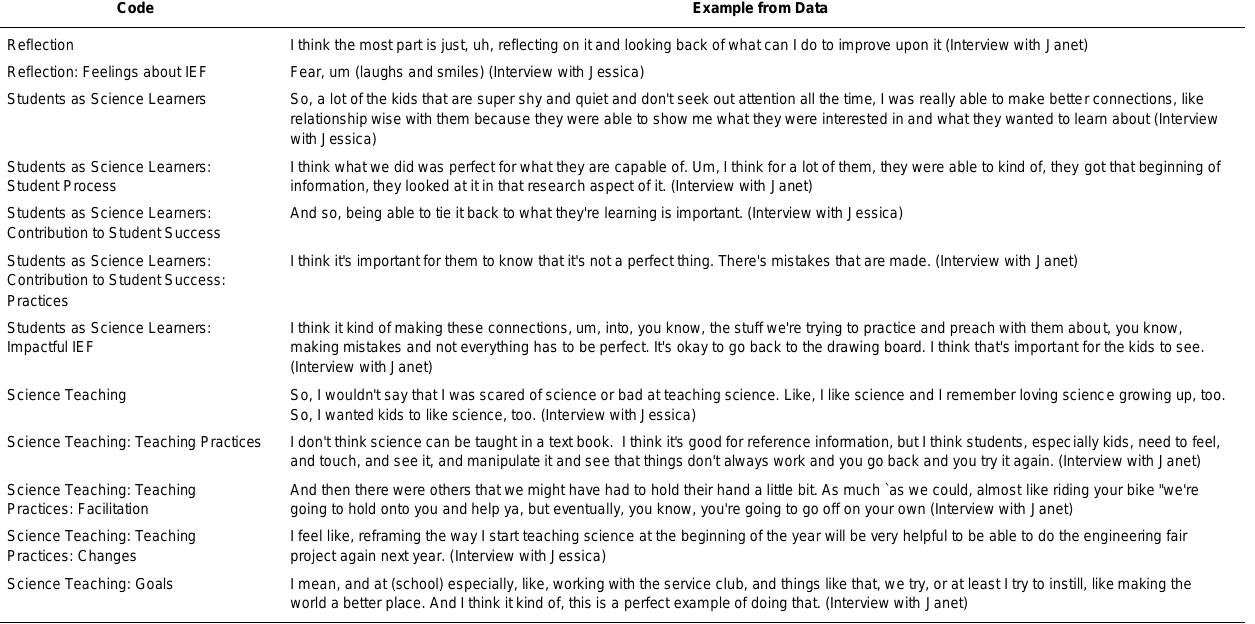
Table 1. Descriptive Codes and Example Data